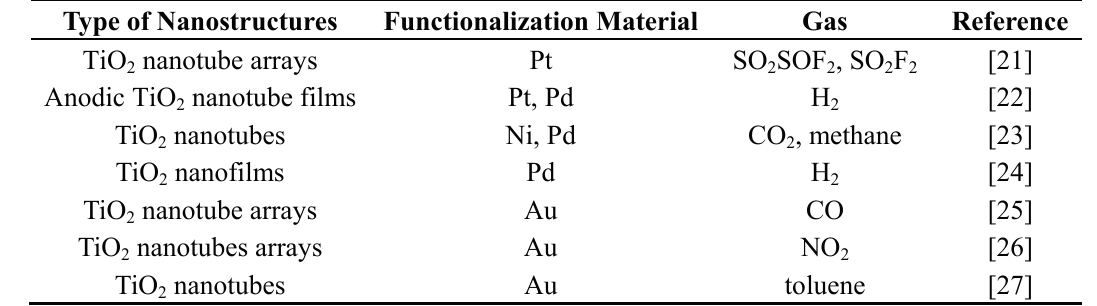
nanotube gas sensors in the 2